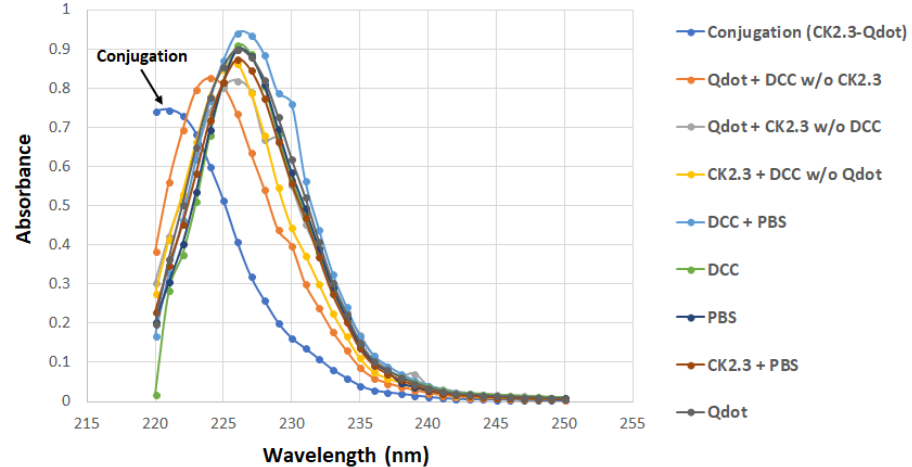
Figure 1. UV/VIS graph representing the absorbance of the CK2.3-Qdot®s fraction, along with the eight other control samples between wavelength 220–250 nm. Conjugated CK2.3-Qdot®s has a distinctive peak compared to its controls, and the absorbance band between 220–225 nm is indicative of secondary amides [45].